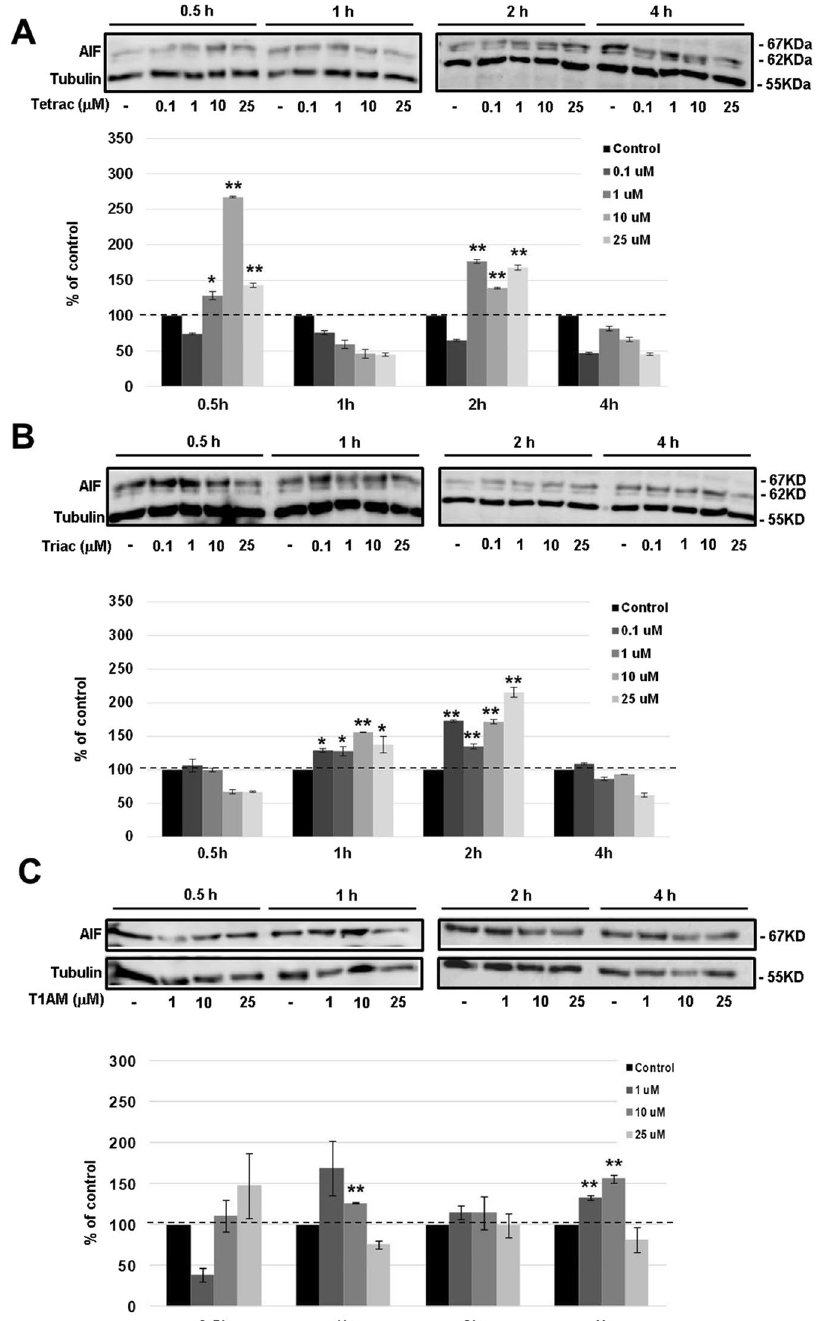
T1AM for 0.5–4 hours and AIF levels were evaluated by Western blots. Representative blot of two independent experiments is presented. * p < 0.05, ** p <